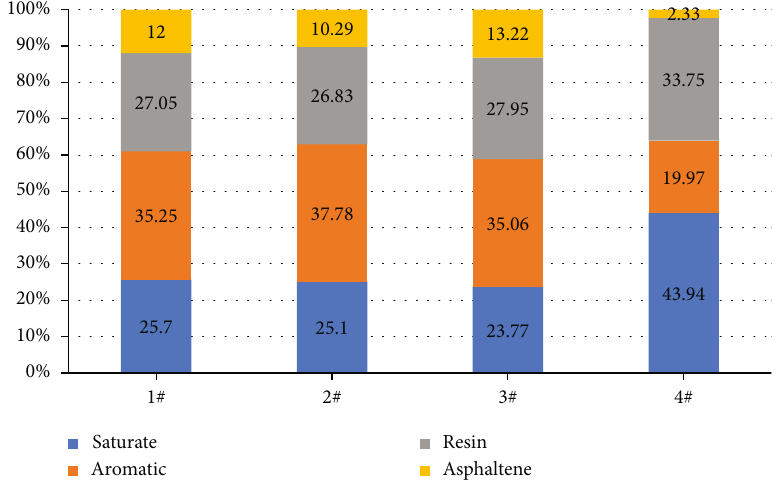
Figure 7: The proportion of four